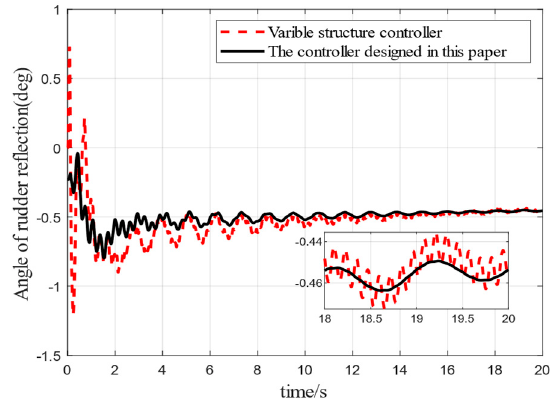
Figure 18. Angle of rudder reflection with external interference.